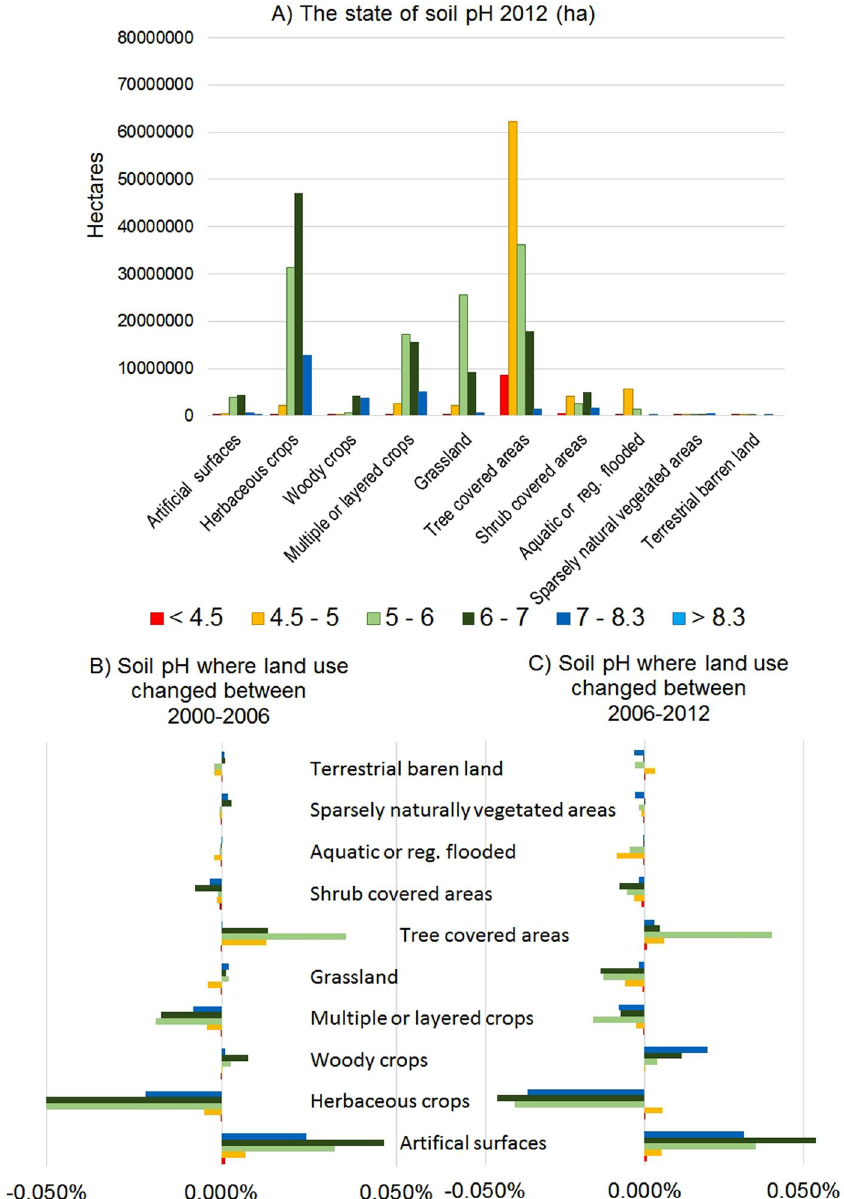
Figure 5. ( A ) The area of land (ha) in the EU-25 study area with pH divided into 6 categories using the LUCAS data. ( B ) The pH of land subject to change of use between 2000 and 2006. ( C ) The pH of land subject to change of use between 2006 and